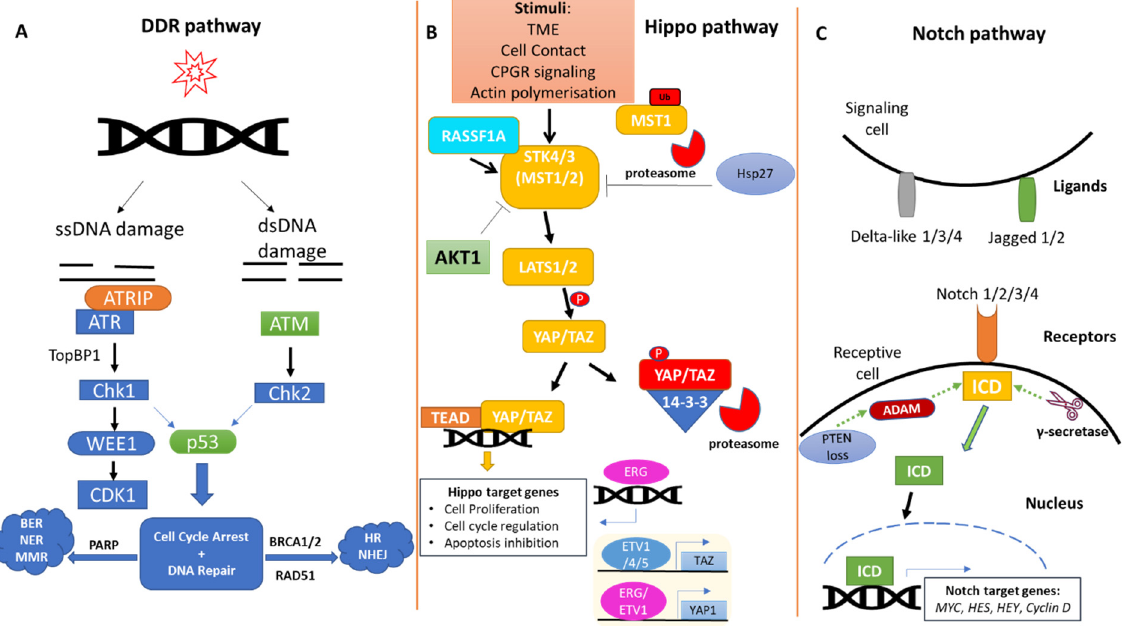
Figure 1. Schematic representation of the DDR, Hippo and Notch signaling pathways in prostate cancer. ( A ) . Mutations in DDR genes including ATM , TP53 , BRCA1/2 and RAD51 are likely implicated in prostate carcinogenesis. The DDR pathway is largely conserved among different types of human cancer. ( B ) . The Hippo kinase cascade is actively involved in prostate cancer. One of the routes through which YAP activity may be affected in prostate cancer is via MST1 kinase ubiquitination and subsequent proteosomal degradation, elicited by the molecular chaperone HSP27. Upon MST1 degradation, YAP translocates to the nucleus where it resumes its transcription coregulator activity. ETS factors and ETS-regulated genes, such as ERG, also have an important role in YAP and TAZ regulation. Especially ERG, apart from regulating the expression of YAP1, it can also bind to YAP1/TEAD binding sites and transactivate Hippo target genes. ( C ) . The Notch pathway is deeply involved in prostate tumorigenesis. When a Notch ligand (Delta-like 1/3/4 or Jagged-1/2) binds to Notch transmembrane receptors (Notch 1/2/3/4), the receptors are cleaved by members of Metalloprotease (ADAM) family and γ -secretase. This cleavage releases the Notch intracellular domain (NICD), which translocates to the nucleus, where it regulates the expression of genes including MYC, HES, HEY, Cyclin D, etc.